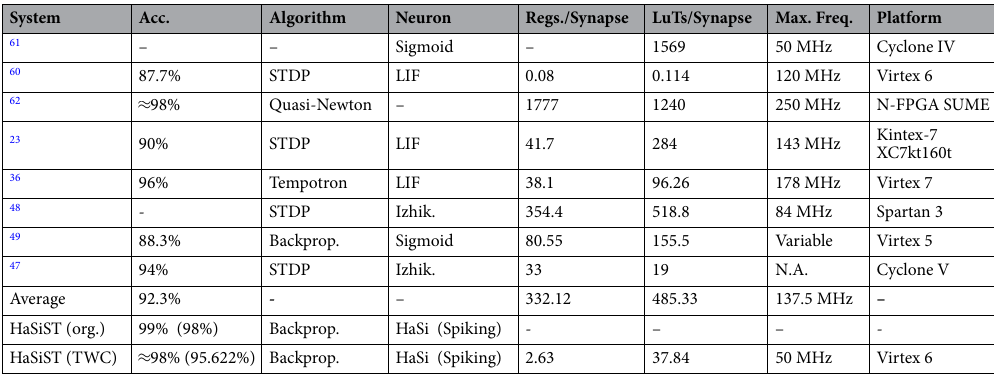
Table 4. Cost comparisons: online learning engines.